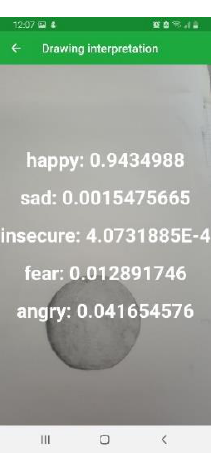
Figure 11. PandaSays drawing interpretation.